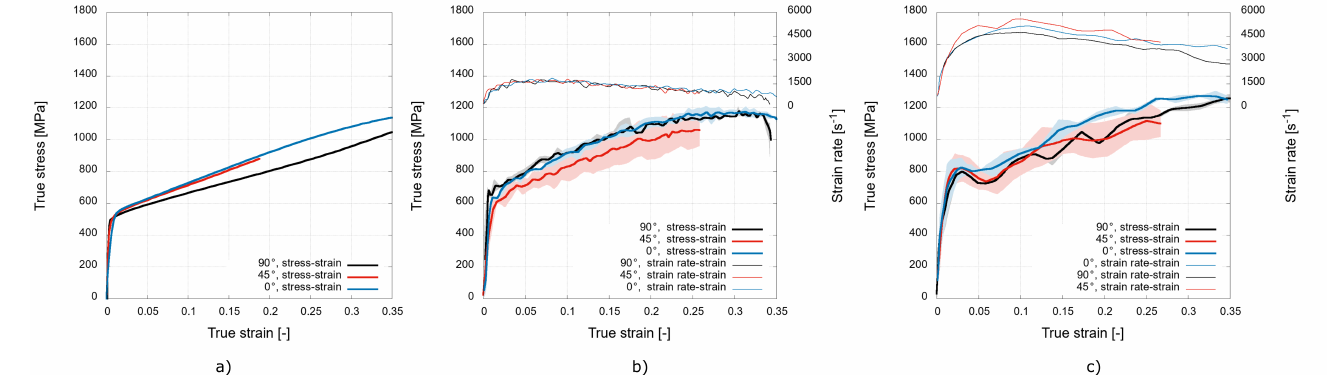
Figure 7. True stress–true strain diagrams evaluated from: ( a ) the quasi-static; ( b ) low rate; and ( c ) high-rate experiments.